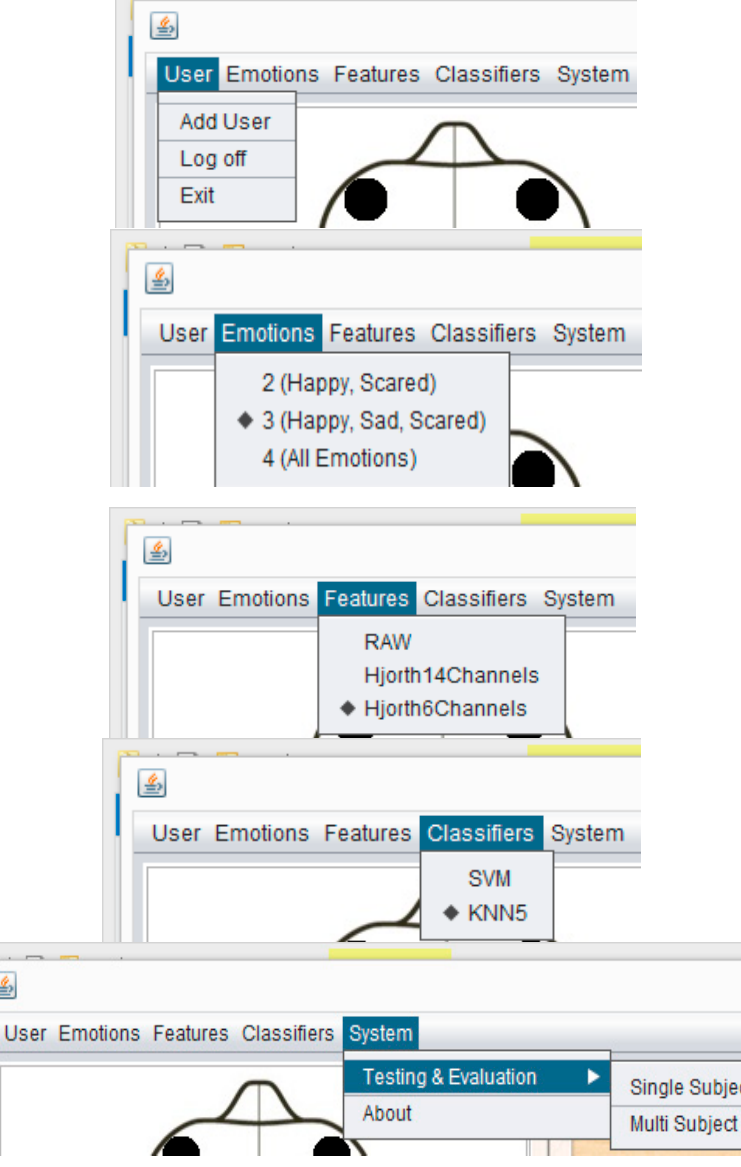
Figure 12. CAES (menu details) shows the menu options of the proposed system. A user can